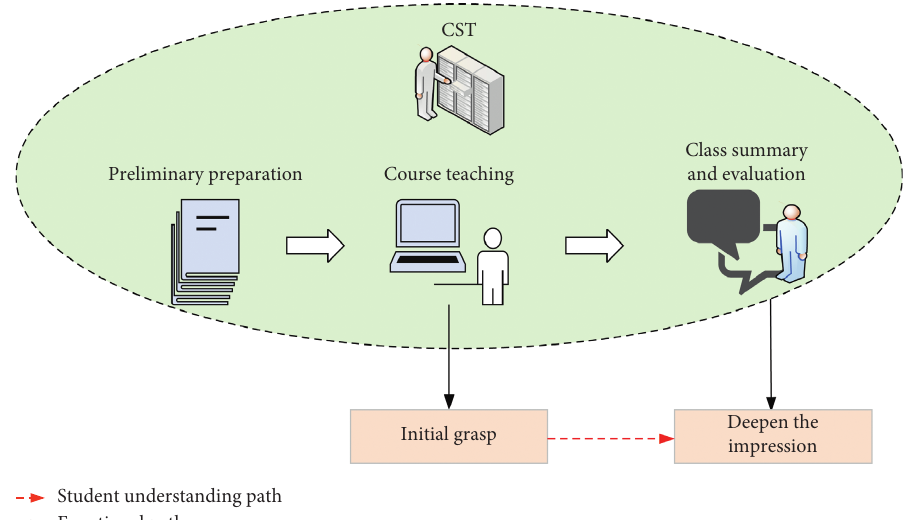
Figure 1: The intelligent I&P teaching mode